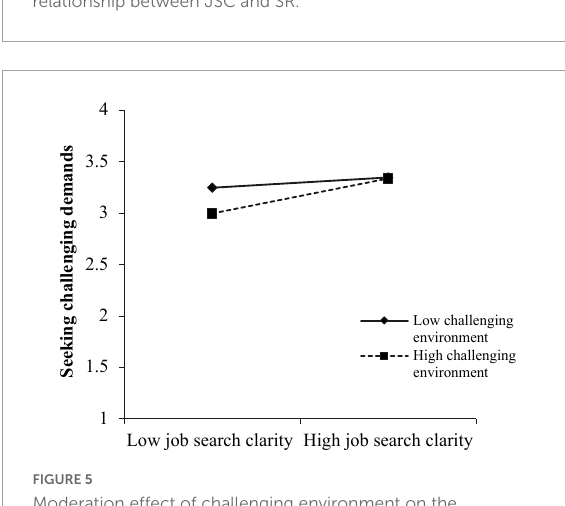
FIGURE4 Moderation effect of challenging environment on the relationship between JSC and SR.